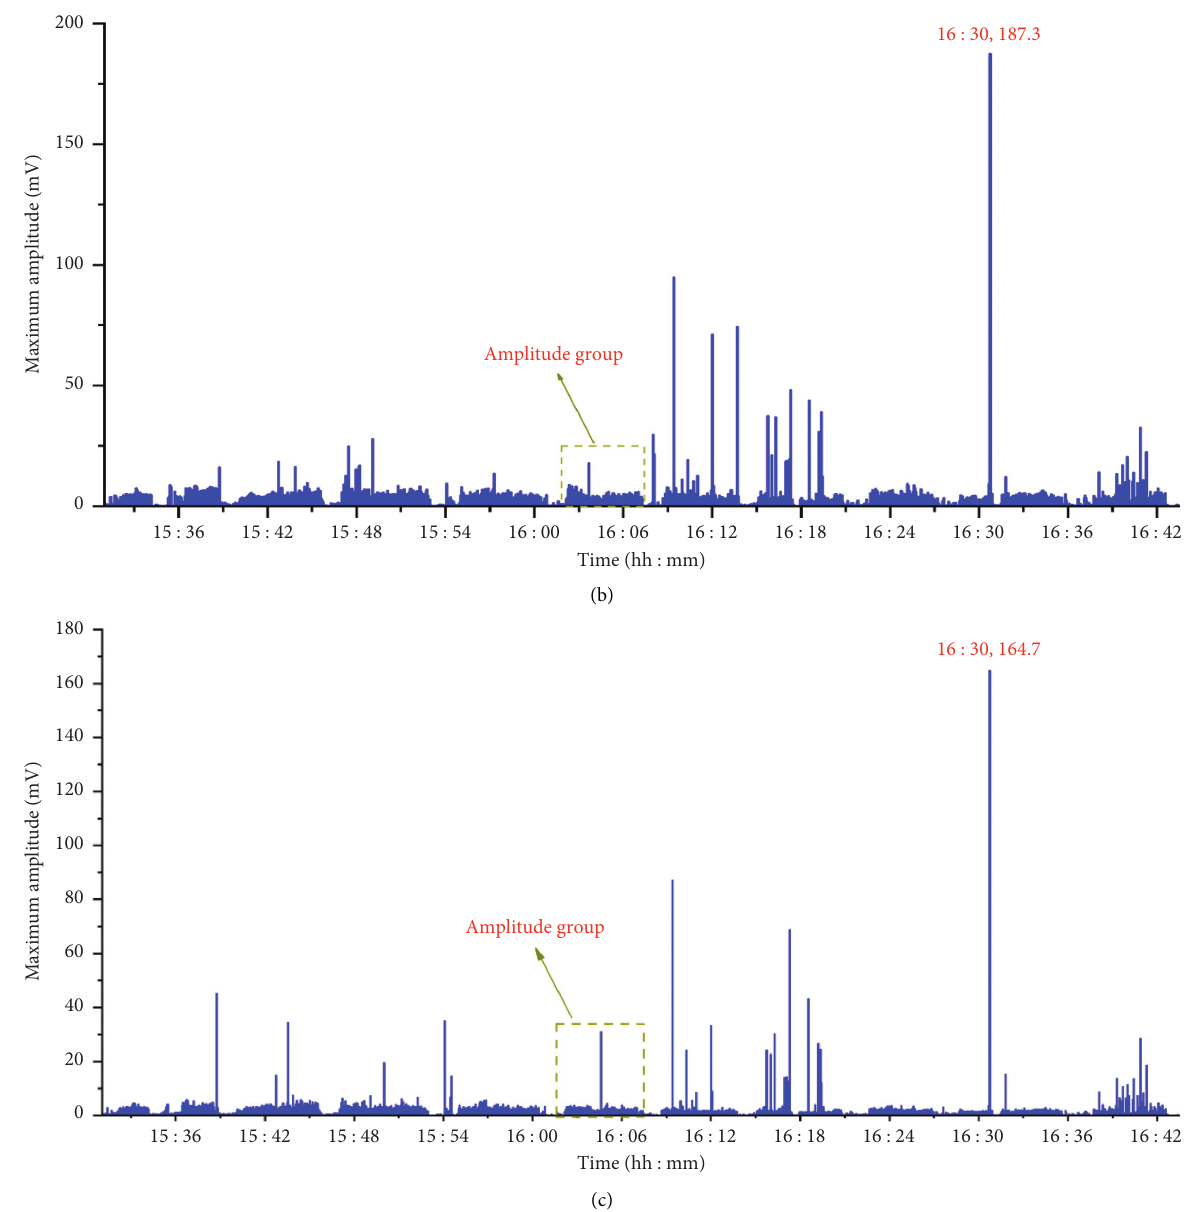
Figure 3: Variation of the maximum amplitude with time. (a) Maximum amplitude tested by 1# detector. (b) Maximum amplitude tested by 2# detector. (c) Maximum amplitude tested by 3#